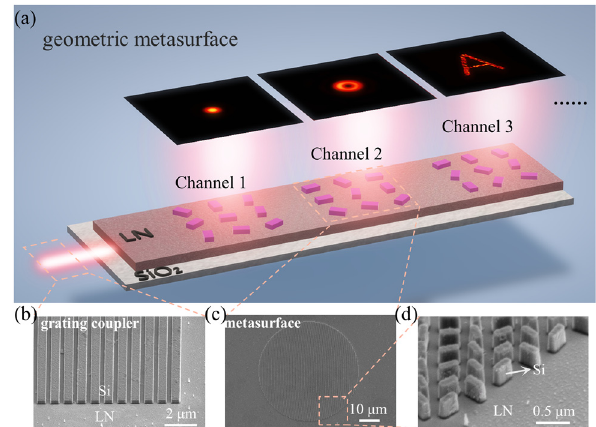
Figure 2: (a) Illustration of the on-chip integrated multifunctional interfaces for LNOI photonic circuit. (b) and (c) Scanning electron microscopy (SEM) images of the fabricated grating couplers and metasurface structures in our experiments. (d) Zoom-in SEM image of the details of the